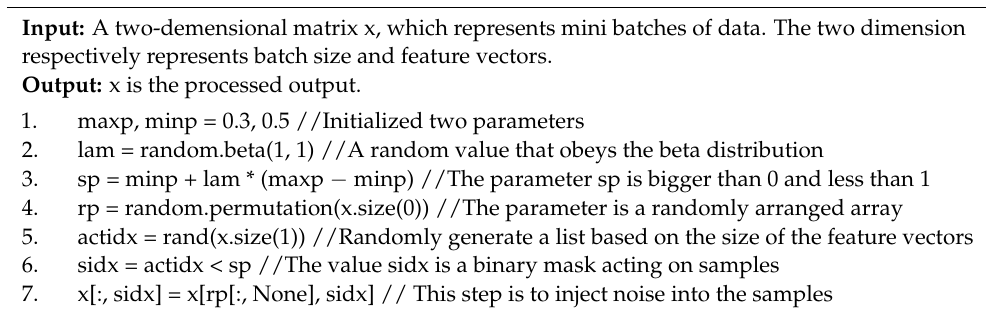
Figure 2. An illustration of the SPS, which shows how SPS exploits samples as a source for noise injection. Algorithm 1. The function of